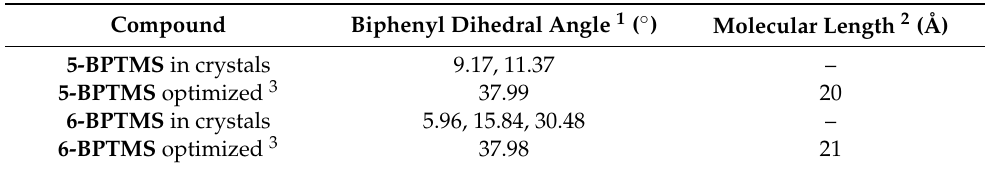
Figure 2. Molecular structures with the smallest C2–C1–C1′–C2′ dihedral angle, as determined by single-crystal X-ray structural analysis at room temperature: ( a ) 5-BPTMS and ( b ) 6-BPTMS . The hydrogen atoms are omitted for clarity. Atom color legend: gray—C; red—O; yellow—Si. Table 1. Key structural parameters of biphenylacetylene compounds determined by single-crystal X-ray structural analysis and DFT calculations.